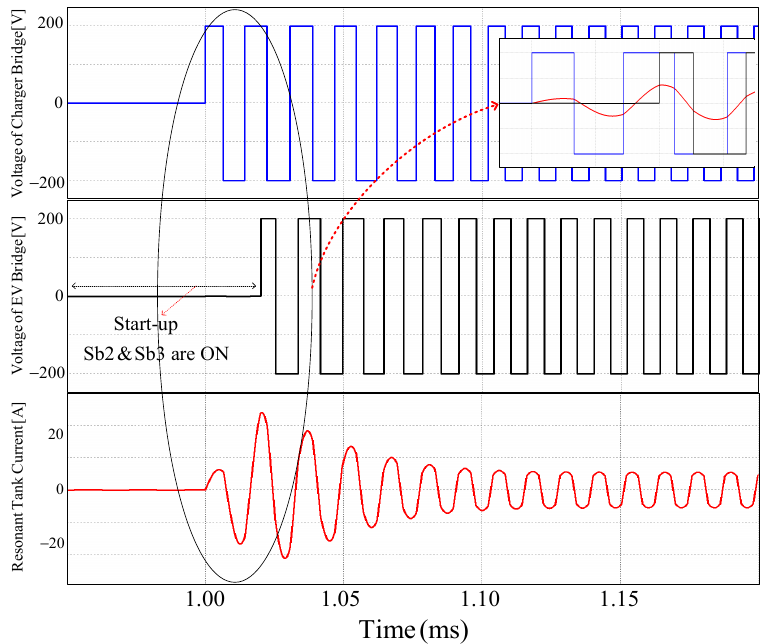
Figure 5. Output voltage of charger bridge, EV bridge and i o under equal voltages at start-up condition with τ 1 = 2 µs and τ 2 = 1 µs.